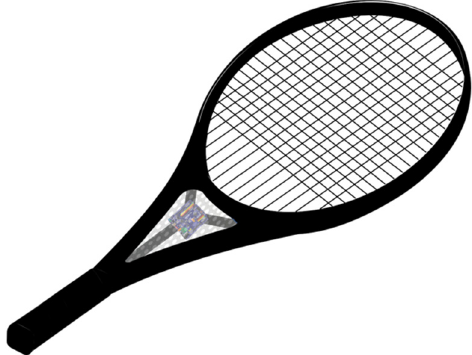
Figure 14. Outlook of a smart racket.